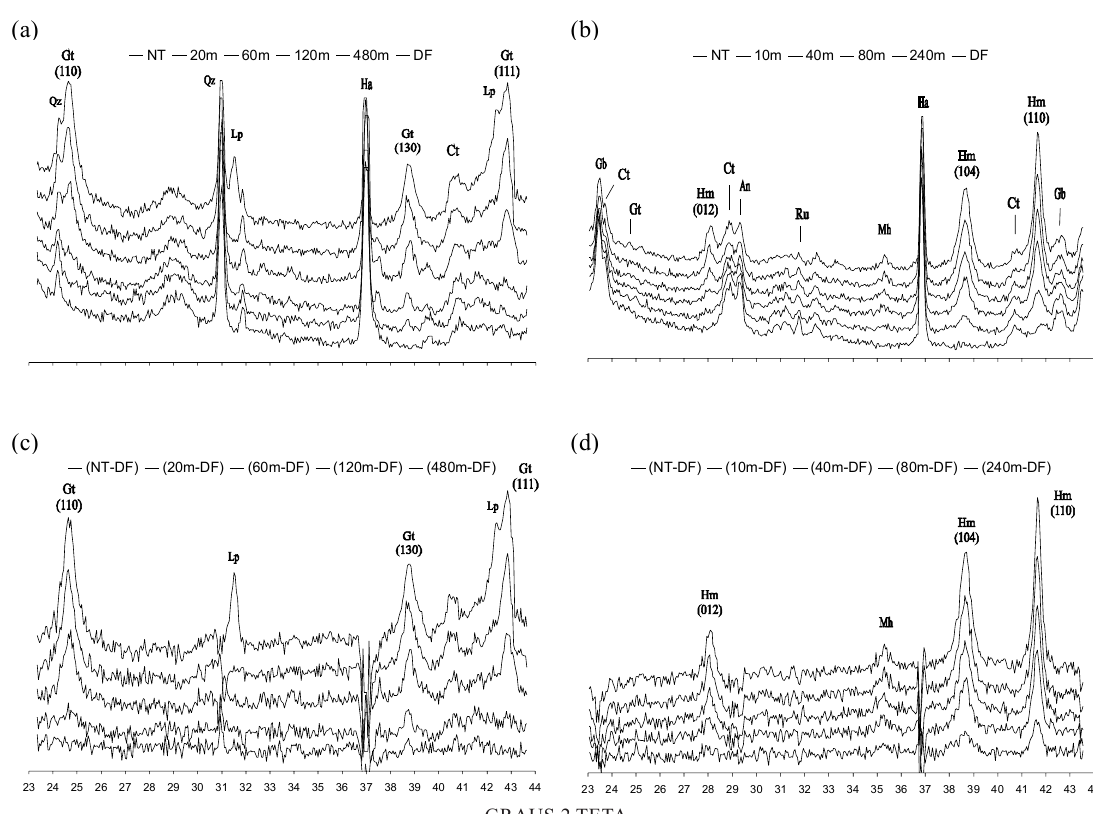
Figura 1. Difratogramas de raios X, em ordem decrescente, da subamostra não tratada (NT), de subamostras tratadas ao longo das dissoluções seletivas (m = minutos) e da subamostra desferrificada (DF) das amostras G7 (a) e H16 (b), e difratogramas diferenciais de raios X das amostras G7 (c) e H16 (d) (ex. (NT-DF) = DDRX da subamostra NT menos a subamostra DF). Gt- goethita; Hm- hematita; Lp- lepidocrocita; Mh- maghemita; An- anatásio; Ru- rutilo; Qz- quartzo; Ct- caulinita; Gb- gibbsita; Ha- halita (padrão